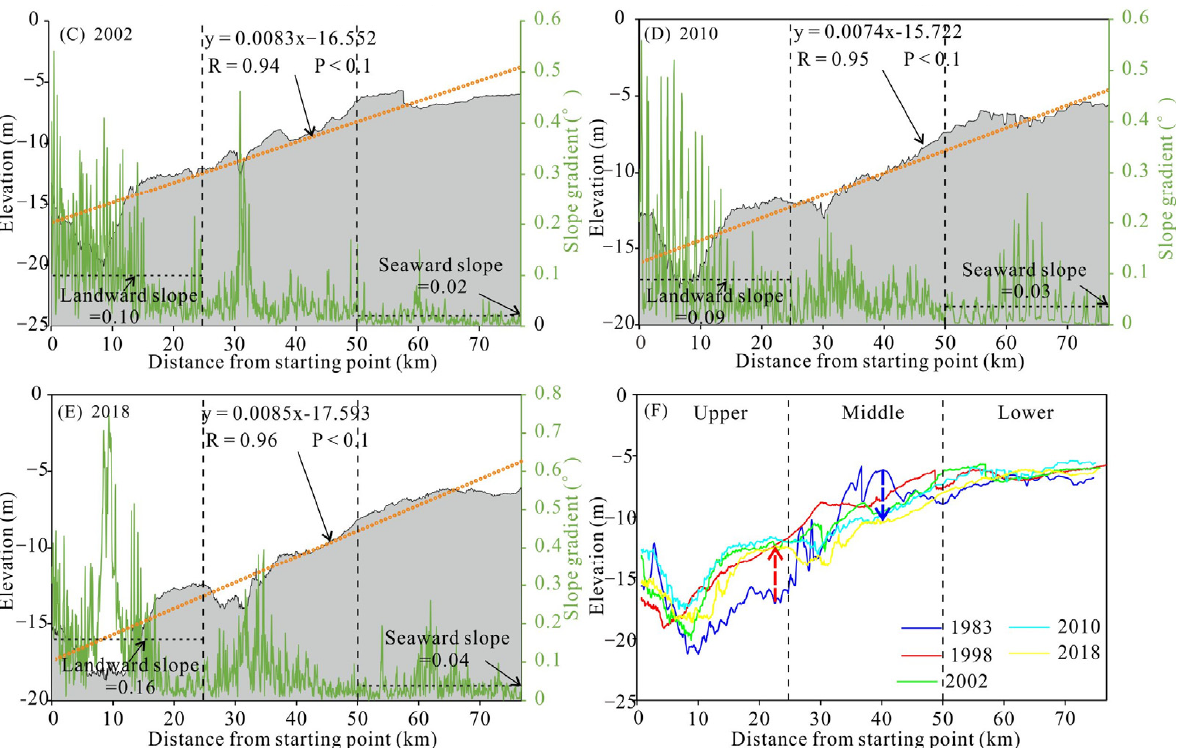
Figure 3. ( A – E ) The longitudinal profiles (black line) (left axis) and channel slope along the channel thalweg (green line) (right axis) of the Yangtze River Estuary during 1983, 1998, 2002, 2010, and 2018. ( F ) Changes in thalweg elevation of the Yangtze River Estuary during 1983–2018. The starting point of the horizontal axis is 4 km upstream of Wusong station (Figure 1C).